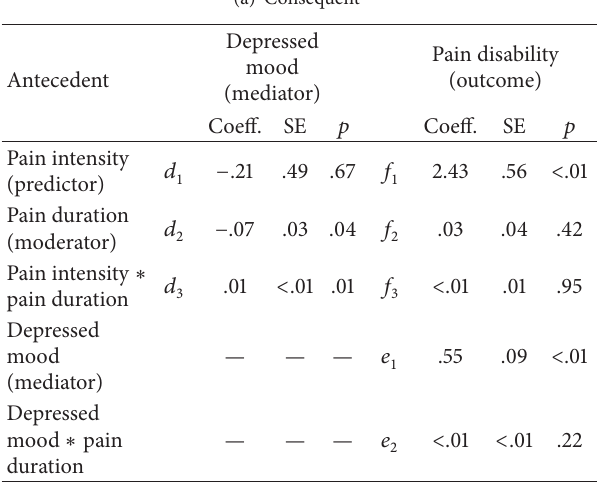
through depressed mood adds novelty to this fact. Our results indicate that preventing and treating depressed mood are highly relevant in chronic pain patients with longer pain durations to reduce the effect of pain on